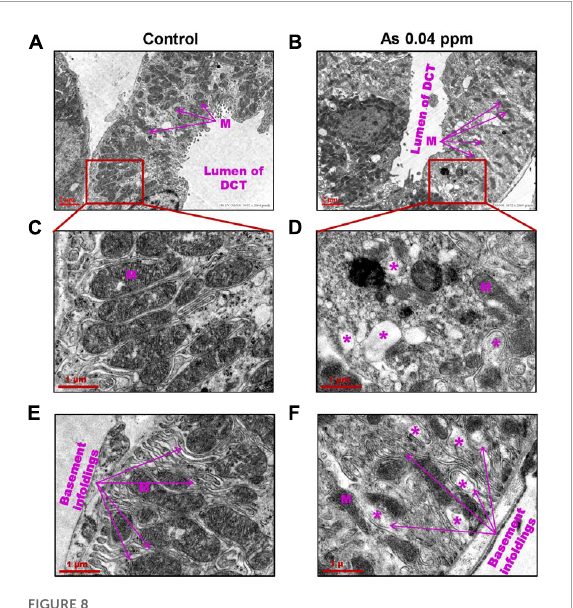
FIGURE8 Prenatal As exposure leads to ultrastructural damages in DCT. The TEM analysis showed damage to the mitochondrial membrane and its cristae. The damaged mitochondria (M) (A–D) and damaged basement membrane infoldings were prominent in 38 weeks old prenatally As exposed animals (E–F) . The asterisk shows the site of damage.